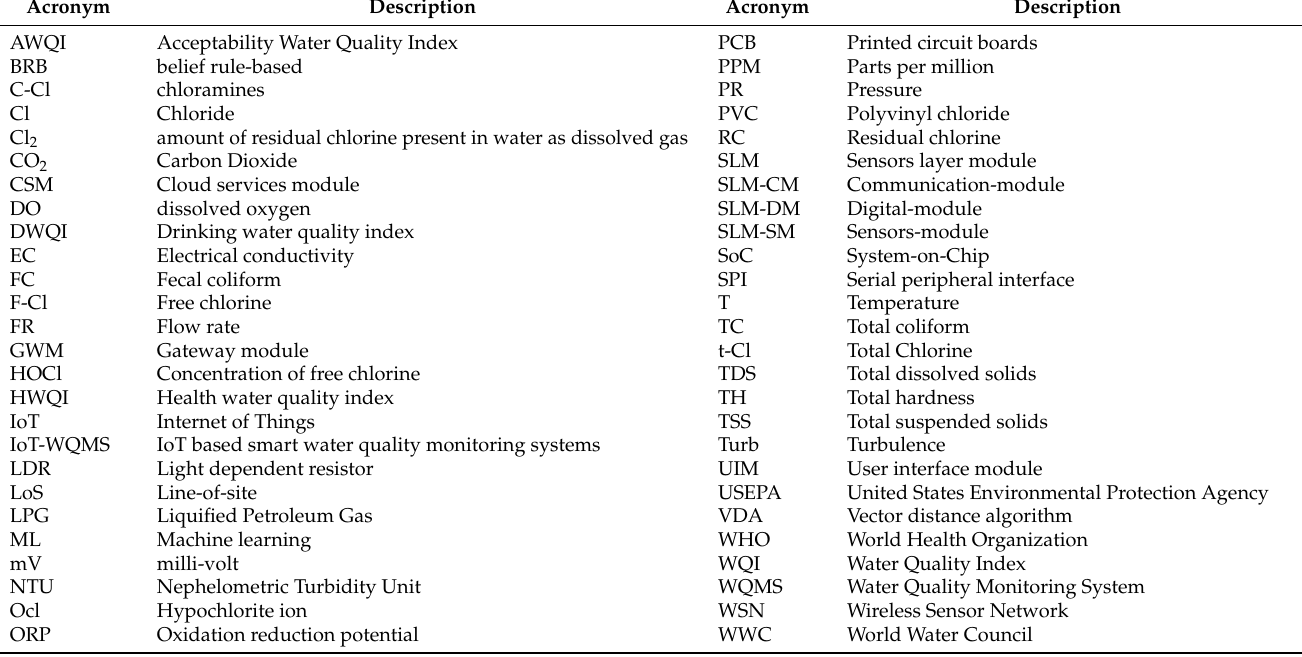
Table 1. Acronyms used in the